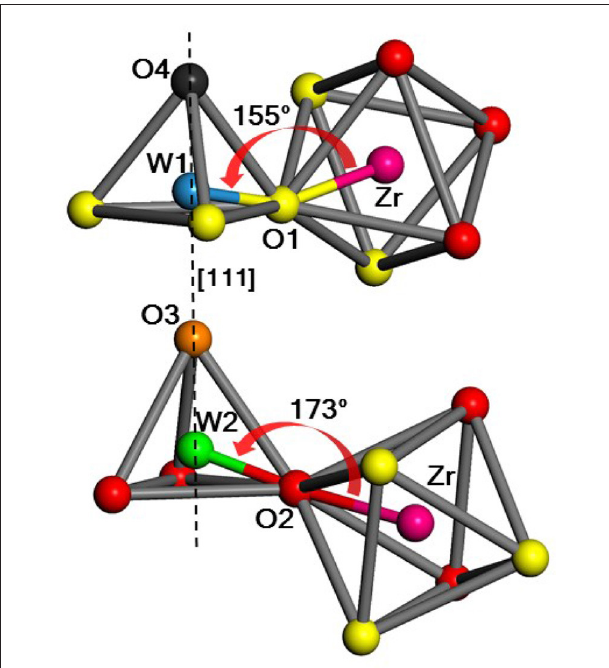
FIGURE 1 | Portion of the unit cell showing the two possible WO 4 –ZrO 6 linkages in ZrW 2 O 8 , with Zr (magenta), W1 (blue) and W2 (green), O1 (yellow), O2 (red), O3 (orange), O4 (black). W1, O1, and W2, O2 are the atoms that form Zr-O-W linkages with bridging angles of 155 ◦ and 173 ◦ , respectively, while the O3 and O4 atoms are only weakly linked ( Table 1 ). [111] denotes the body diagonal direction of the unit cell.